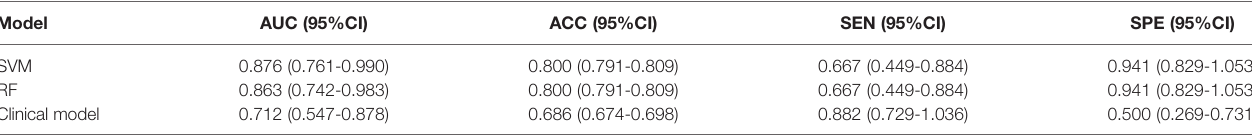
TABLE 2 | Comprehensive performance of prediction models for predicting NSCLC subtypes in the validation group. Model